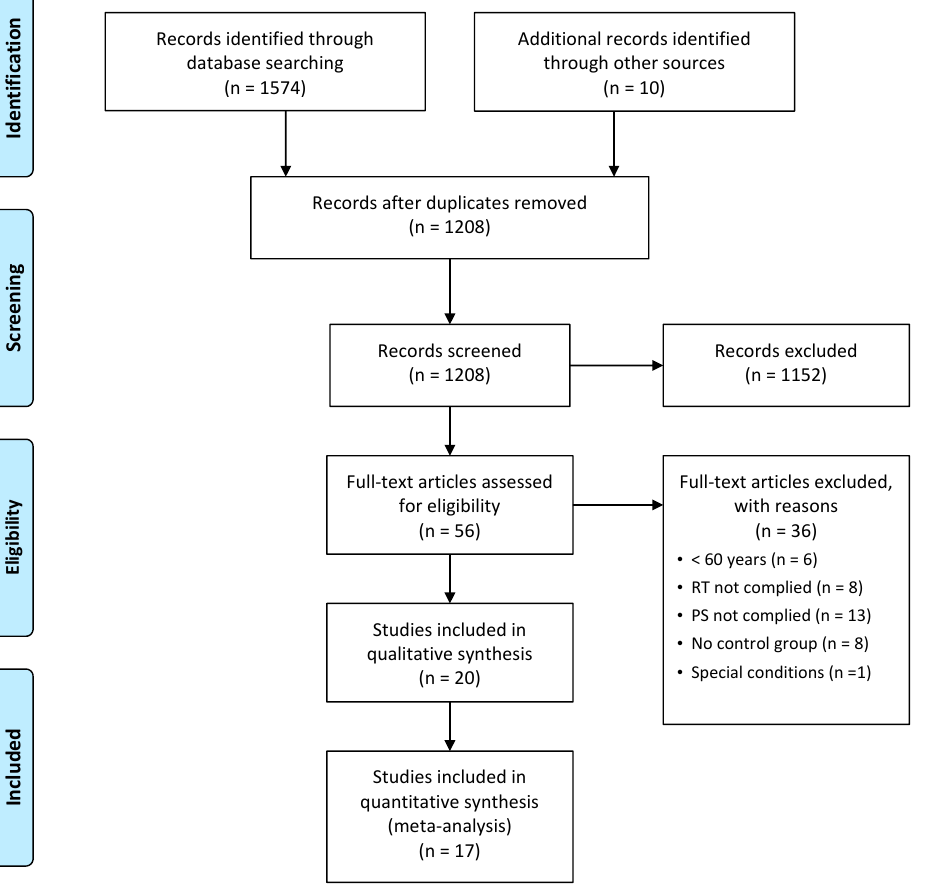
Figure 1. Flow diagram of the literature search and selection process. PS protein supplementation; RET resistance exercise